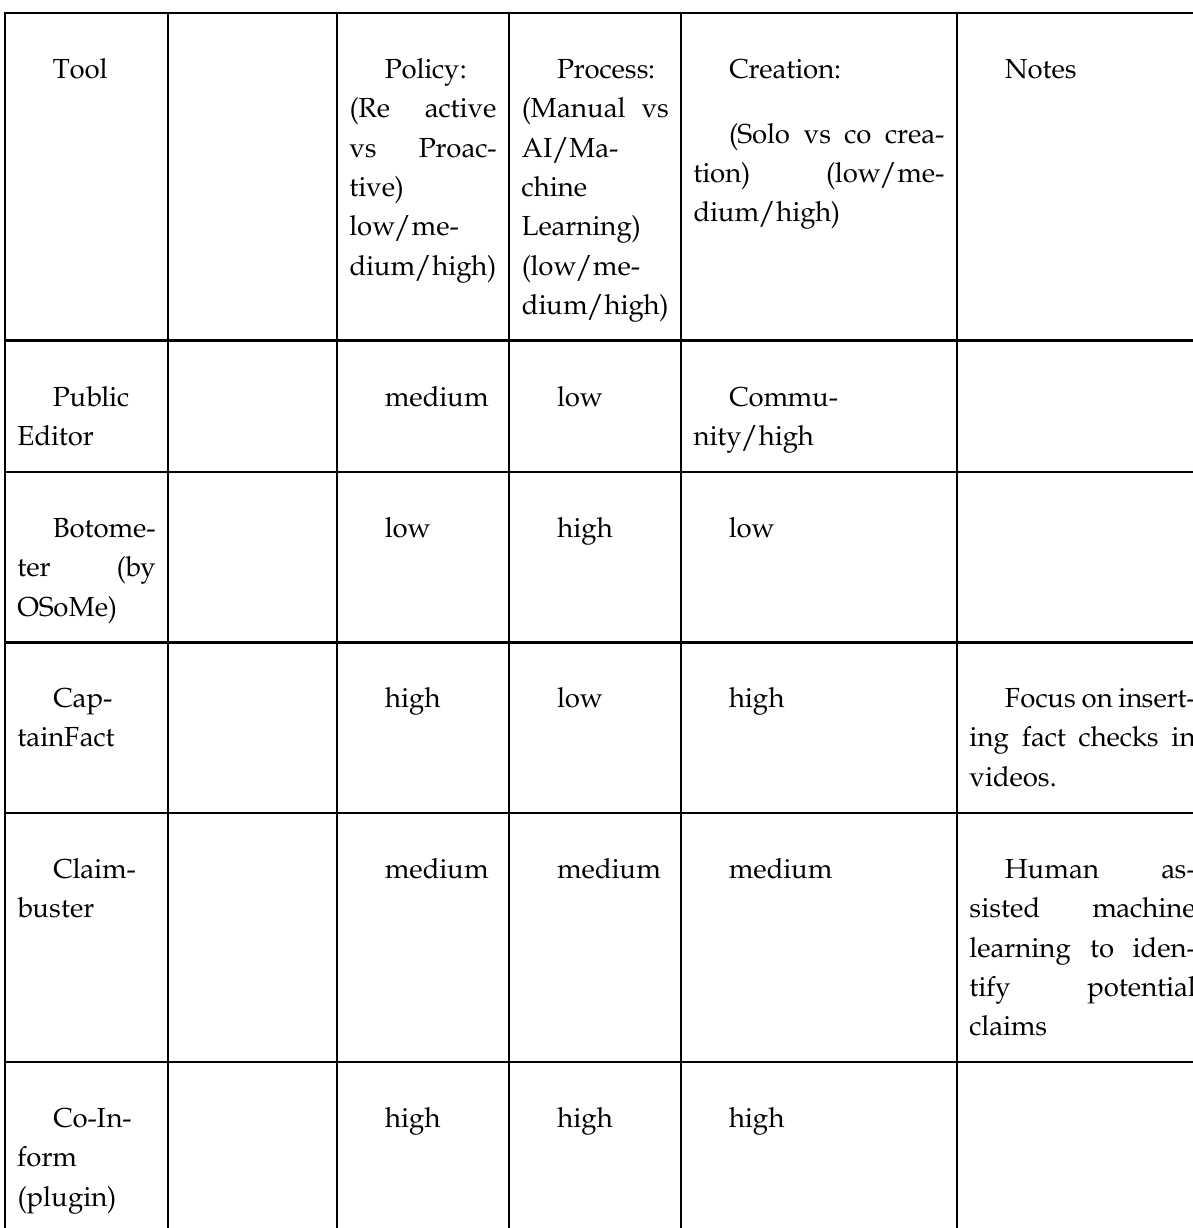
Table 1. Evaluation of the qualities of the selected items. For the three categories (i.e., policy, process, co-crea- tion) each item is evaluated under three possible degrees, high, medium or low. The outcomes of this evalua- tion are reported visually in the